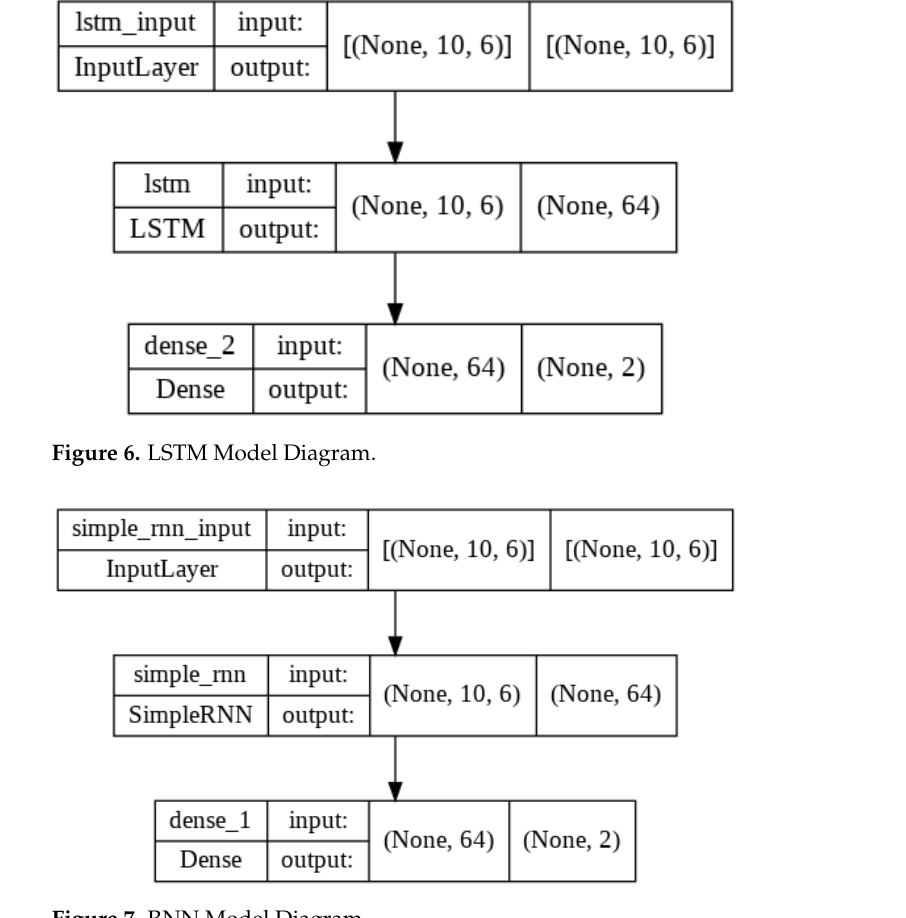
Figure 7. RNN Model Diagram. Table 3. Model